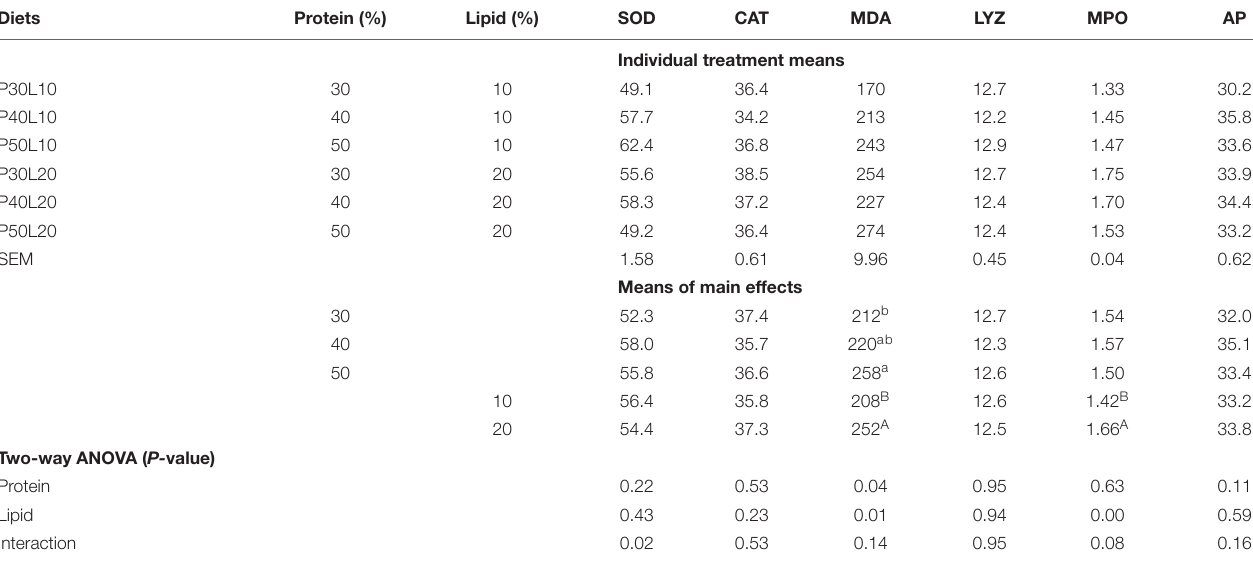
TABLE 8 | Serum antioxidant and innate immune parameters at 24 h post-feeding in European grayling ( Thymallus thymallus ). Diets Protein (%) Lipid (%) SOD CAT MDA